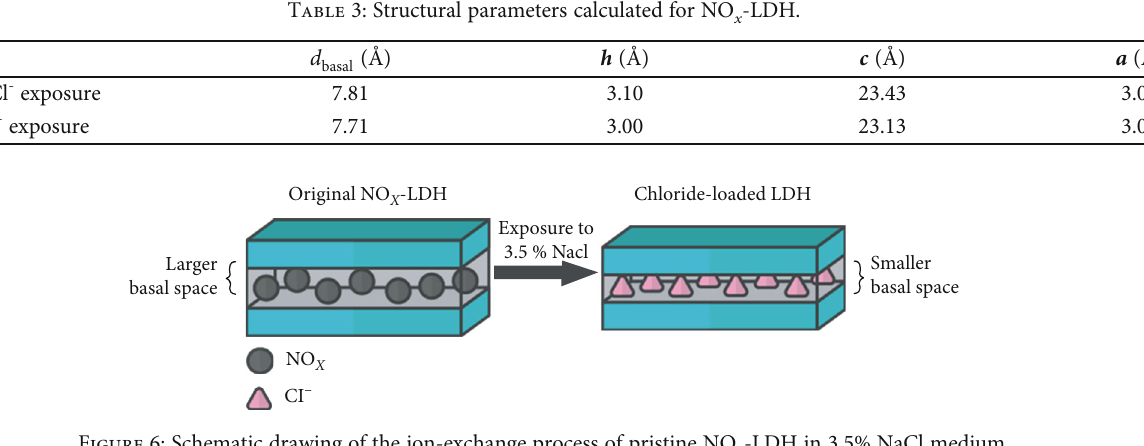
-LDH in 3.5% NaCl medium. x